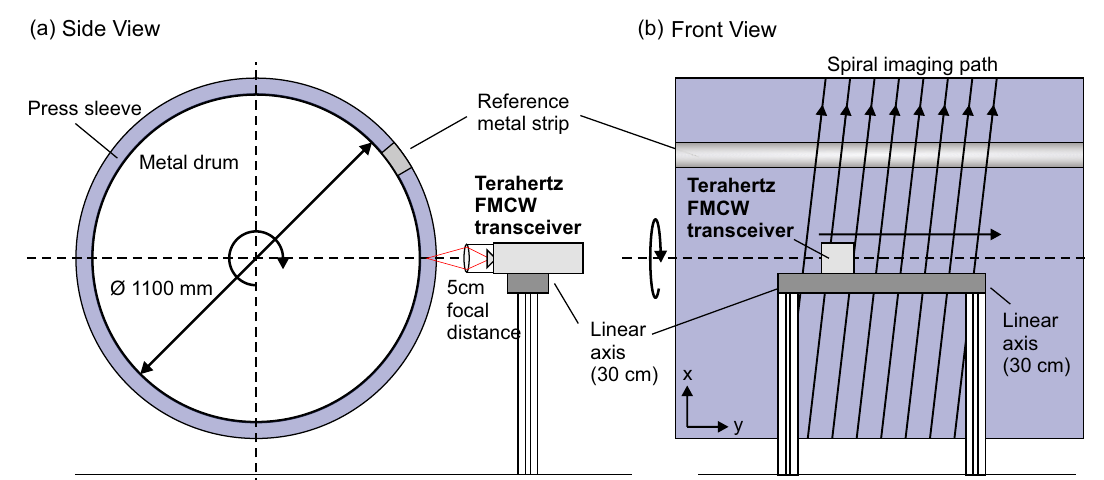
Figure 2. Measurement scheme of the terahertz imaging setup for the investigation of paper press sleeves. ( a ) Side view showing the terahertz FMCW transceiver with 50 mm focusing optics mounted on a linear axis and placed in front of the rotating sleeves at the height of the rotational axis. ( b ) Front view. During measurement, the terahertz transceiver moves along the linear axis and terahertz volumetric data is recorded along the indicated spiral imaging path. An attached metal strip serves as rotation reference with a peak in the terahertz reflection signal on every